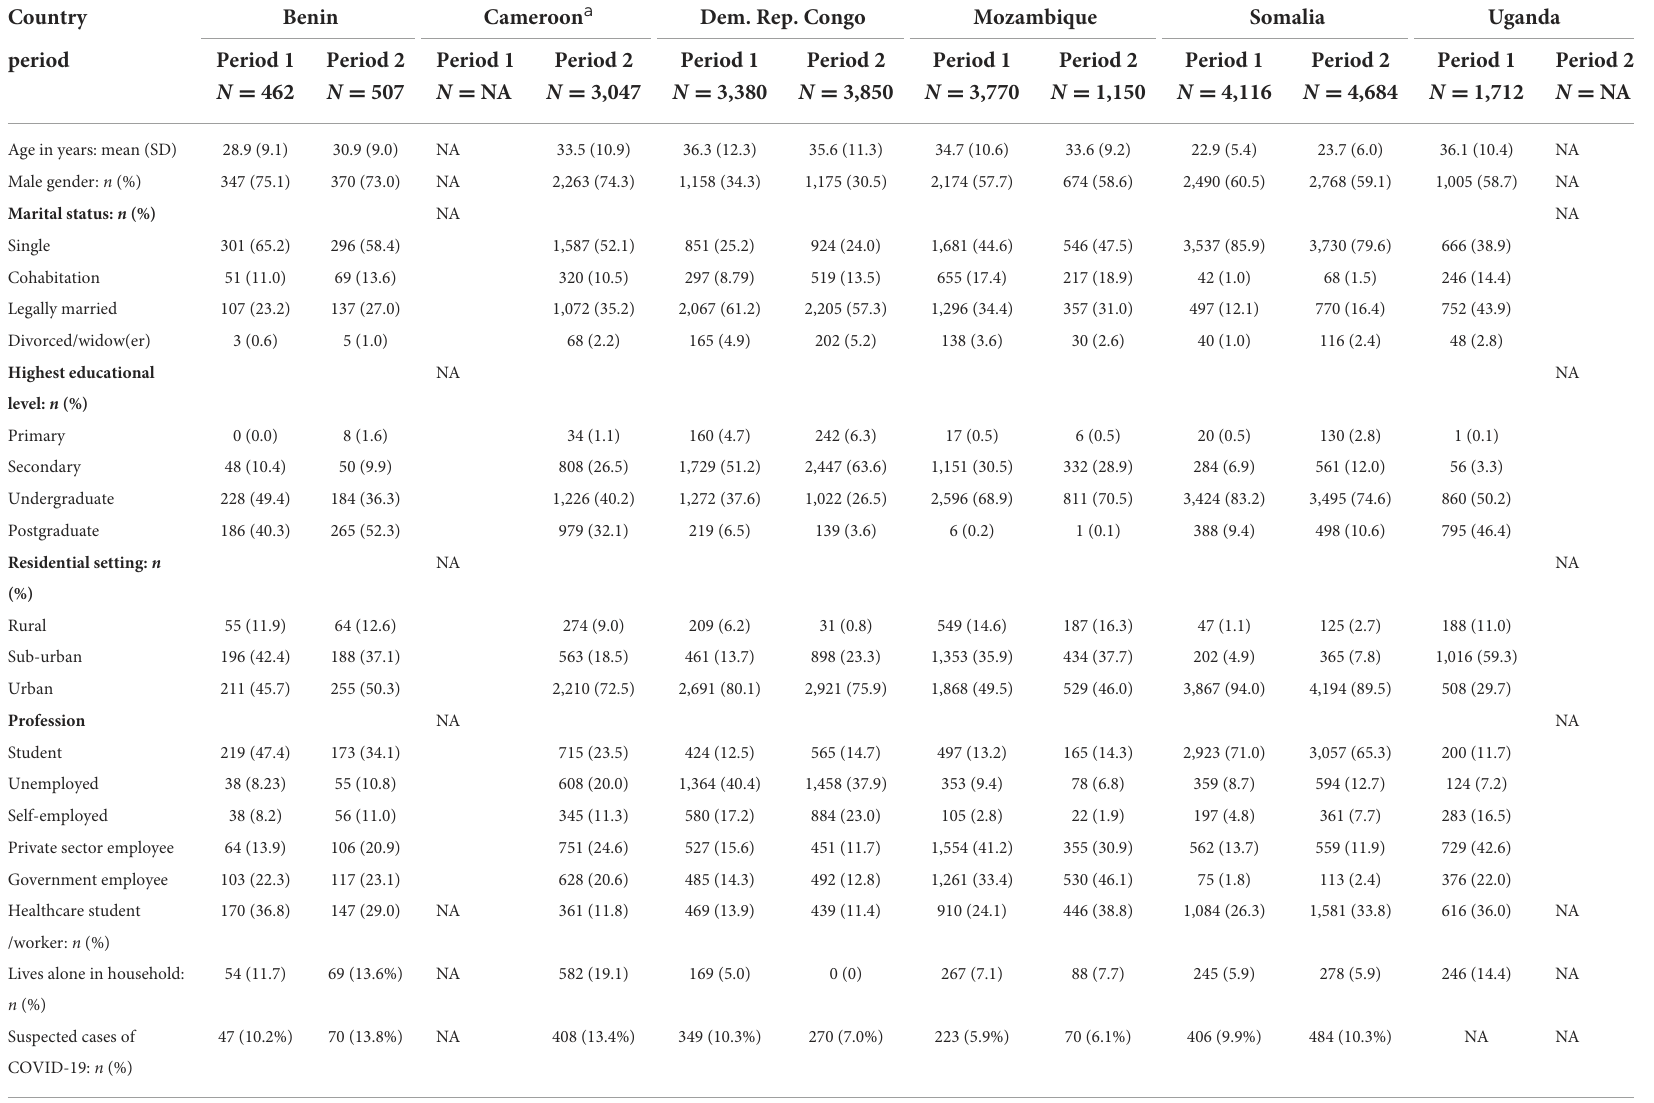
TABLE 1 Participant characteristics by study